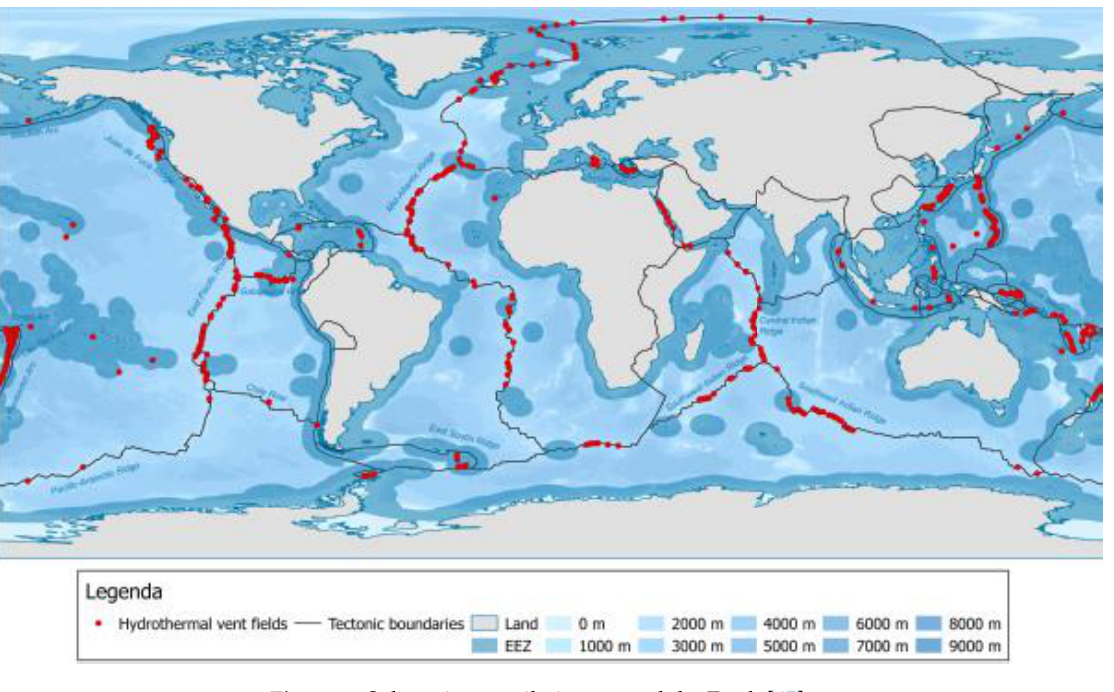
Figure 7. Submarine ventilation around the Earth [65].